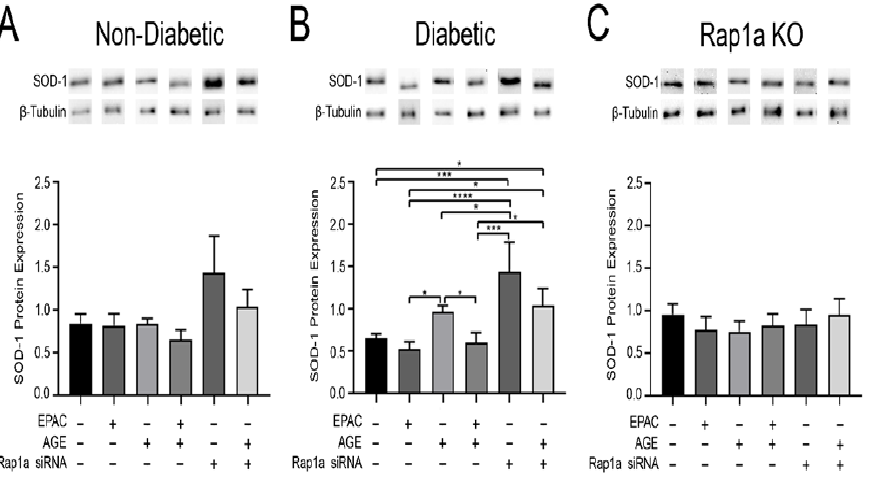
Figure 5. Reduced Rap1a expression caused increased SOD-1 expression. ( A ) Non-diabetic, ( B ) diabetic, and ( C ) Rap1a KO cardiac fibroblasts were isolated and treated with different combinations of EPAC (100 µ M), AGE (0.5 mg/mL), and Rap1a siRNA (100 nM). SOD-1 (23 kDa) protein expression was normalized to β -tubulin (55 kDa) protein expression. Data depicted for exogenous AGE treatment group for non-diabetic and diabetic fibroblasts were previously presented Figure 1. Representative western blot images are shown above graphs but are not displayed as a continuous blot due to running order on the blot not aligning with graphical order of samples. However, original western blot images are available at DOI:10.6084/m9.figshare.12625409. Mean ± SEM are depicted in graphs (n = 7–9) with significance determined by one-way ANOVA followed by a Fisher’s protected least significant difference post hoc (* p < 0.05, *** p < 0.001, **** p < 0.0001).